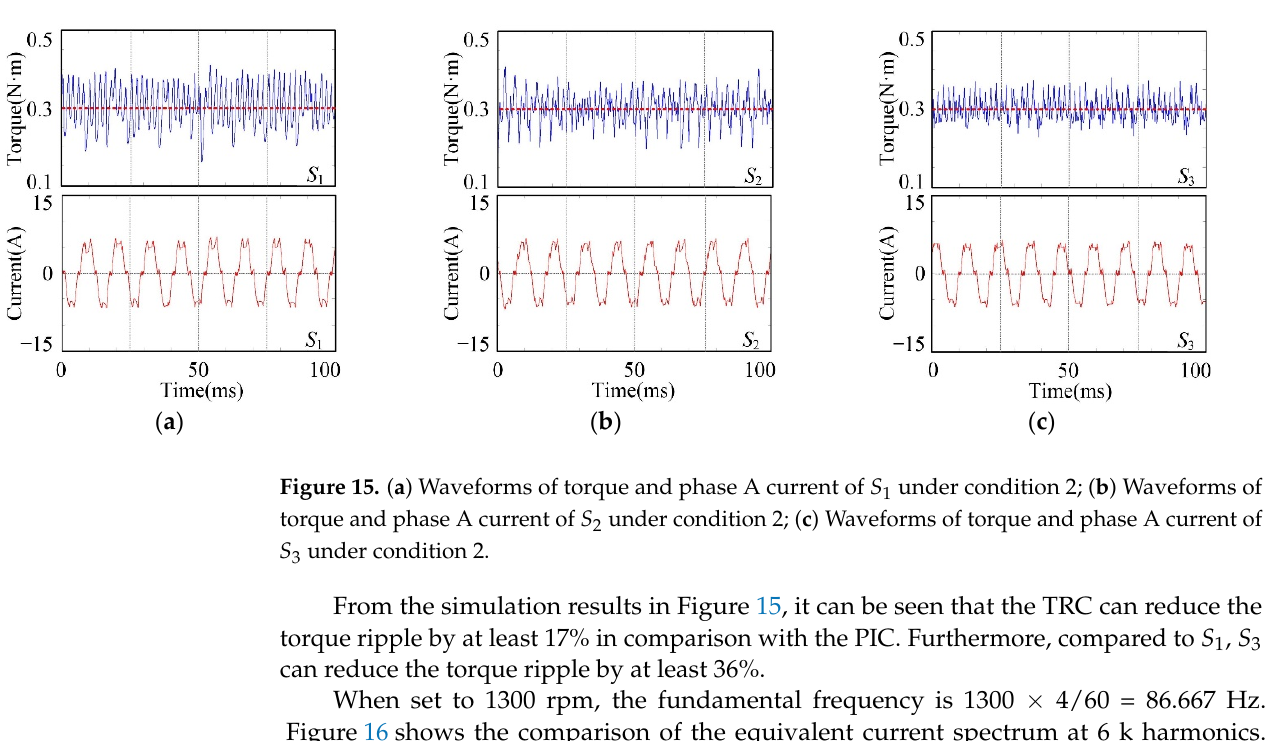
Figure 16. Equivalent current spectrum diagram of S 1 , S 2 and S 3 under condition 2.